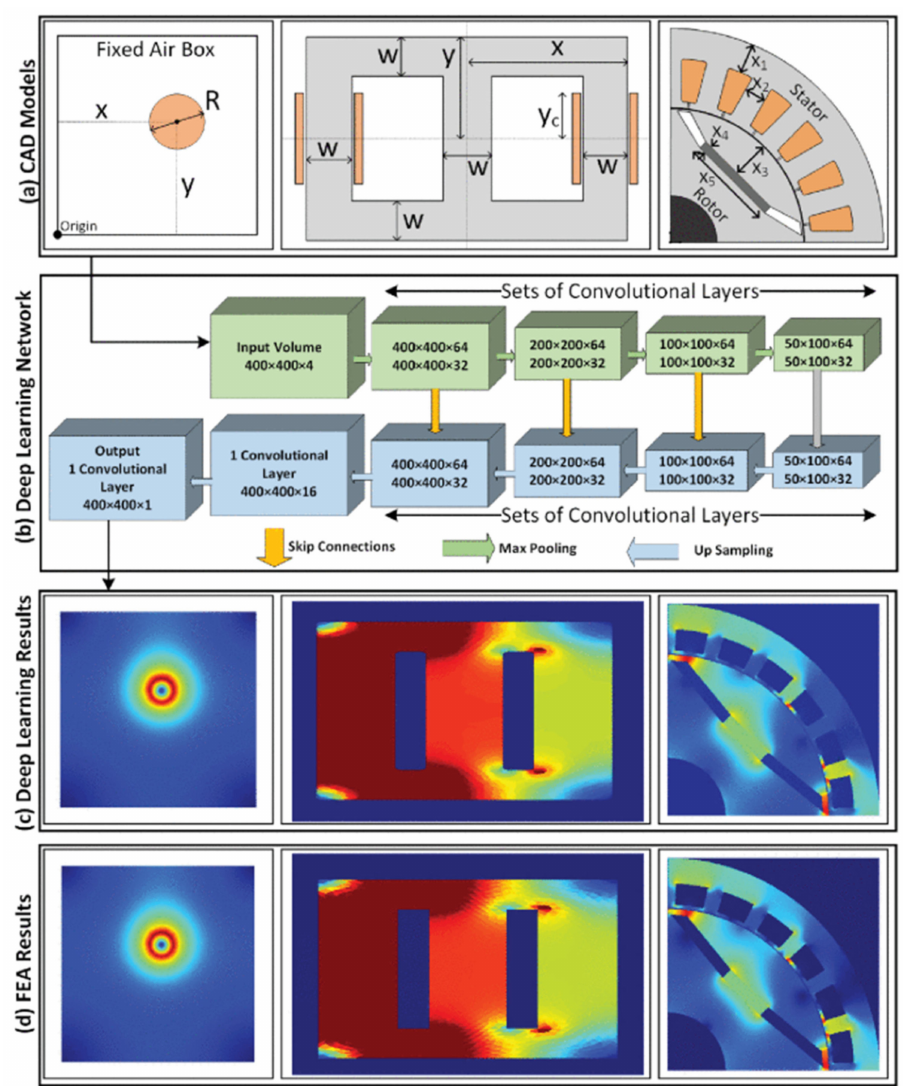
Figure 9. ( a ) Geometrical definitions, ( b ) learning network, ( c ) field predictions, ( d ) finite element results [28]. Reprinted with permission from